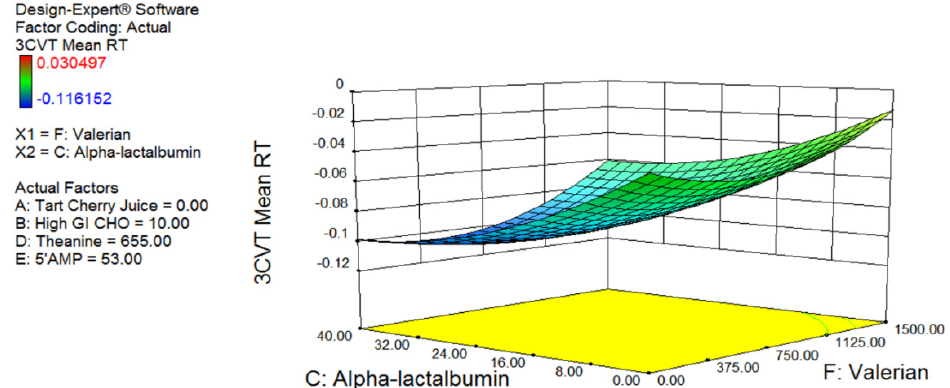
Figure 2. Quadratic response surface plot highlighting the effect of α‐ lactalbumin and valerian on three-choice vigilance task (3CVT) scores. A decrease in 3CVT score indicates greater sleepiness. The response surface represents all 55 measures. The 5 ′ AMP linearly shifted the response down and is shown at its highest level. Theanine and high GI CHO had variable effects and are shown at their optimal.